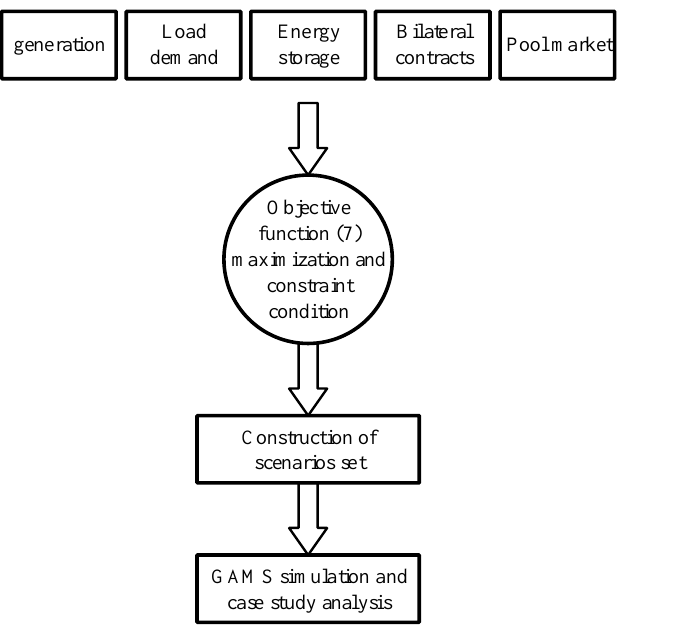
Figure 3. VPP optimization method chart.